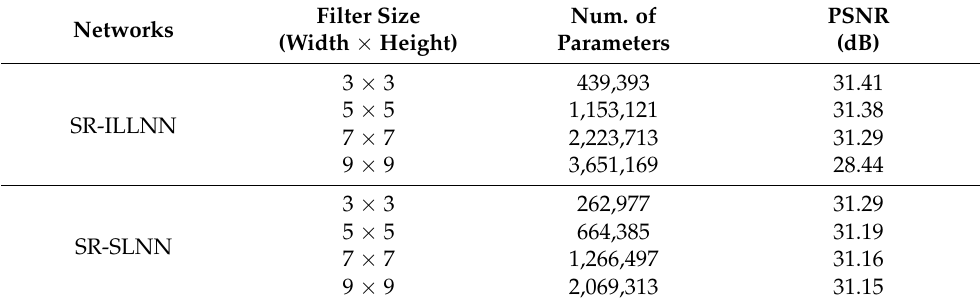
Table 4. Relation between the number of parameters and PSNR according to the various filter